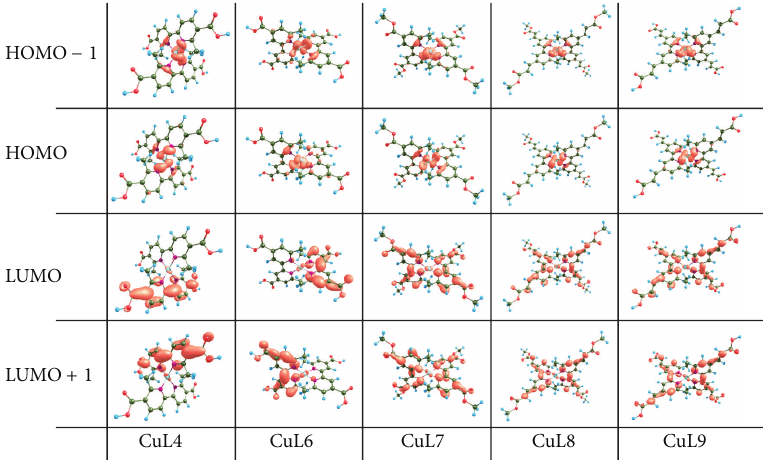
Figure 3: Molecular orbitals for Cu complexes calculated at the M06/LANL 2 DZ + DZVP level of